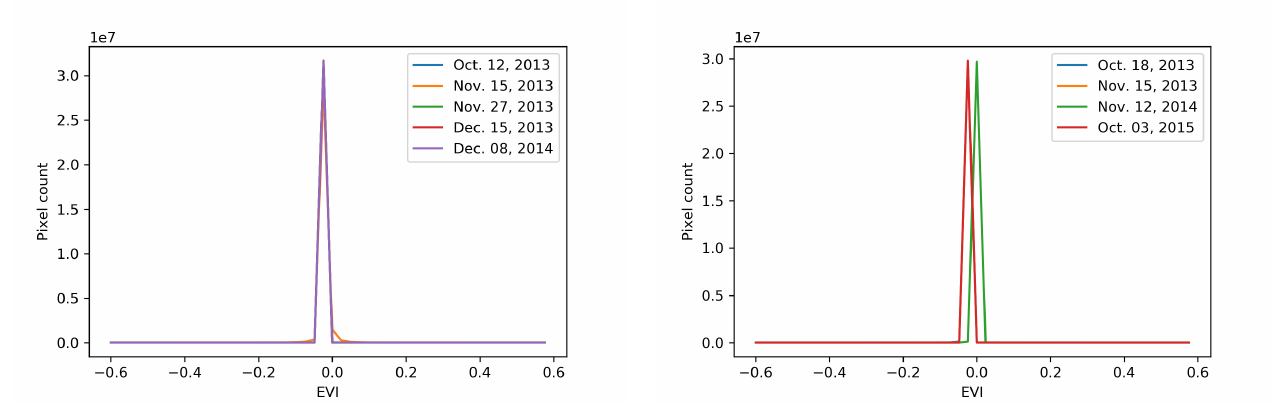
Figure 6. Histogram of biomass indicators for the Guiuan ( left ) and Tacloban ( right ) study sites.